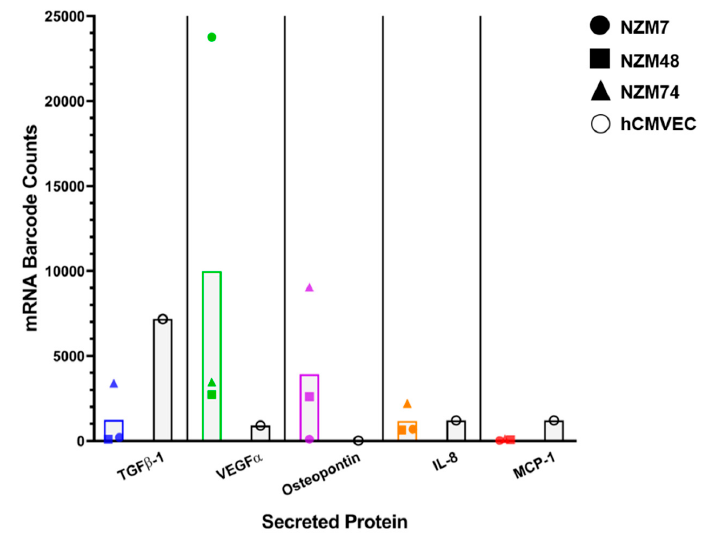
Figure 3. NanoString analysis of the expression of TGF β -1 mRNA transcripts in melanoma and brain endothelial cells. Coloured points show transcript expression of three different NZM lines per secreted protein. Black points show expression in the brain endothelial cells for the same secreted proteins.